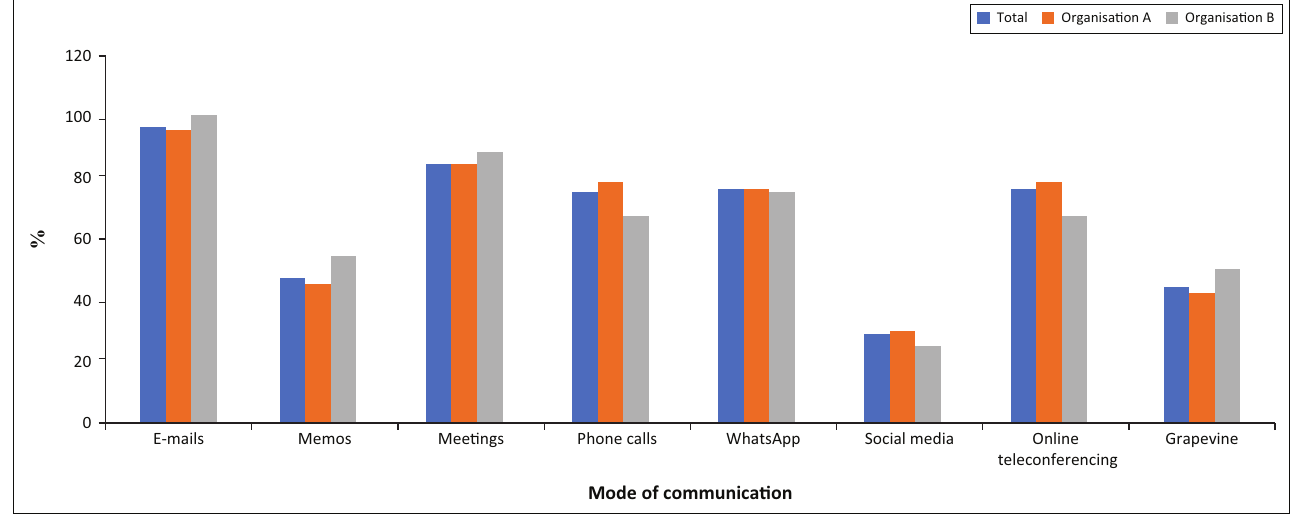
FIGURE 2: Types of communication